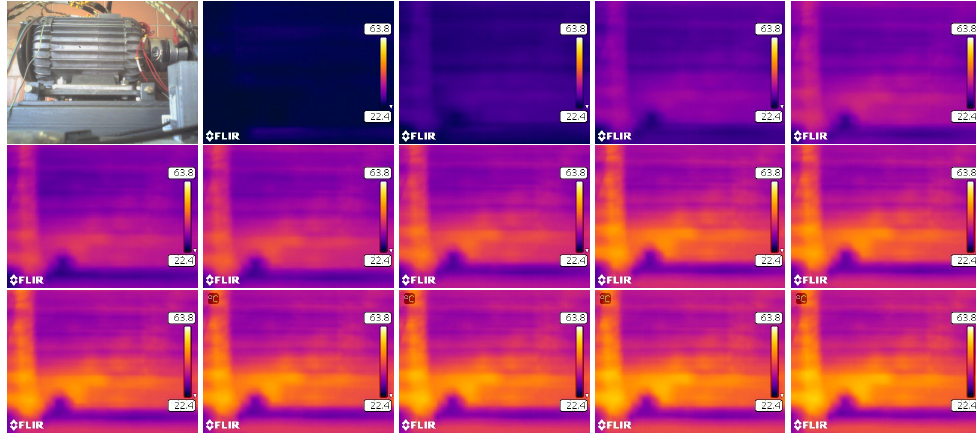
Figure 27. Research images from a thermal imaging camera heating applied to test our engine, photos are taken with time step ∆ t = 15 min. Table 5. Summary of temperature increases to the steady state for selected moments of load and set centrifugation speeds, where M N is the rated torque of the motor and n N is the rated speed of the motor where the sensor out means the use of the external disk and the sensor in means the sensors placed in the engine for selected frequencies of the PWM signal: f 1 ≈ 35 kHz, f 2 ≈ 18 kHz, f 3 ≈ 9